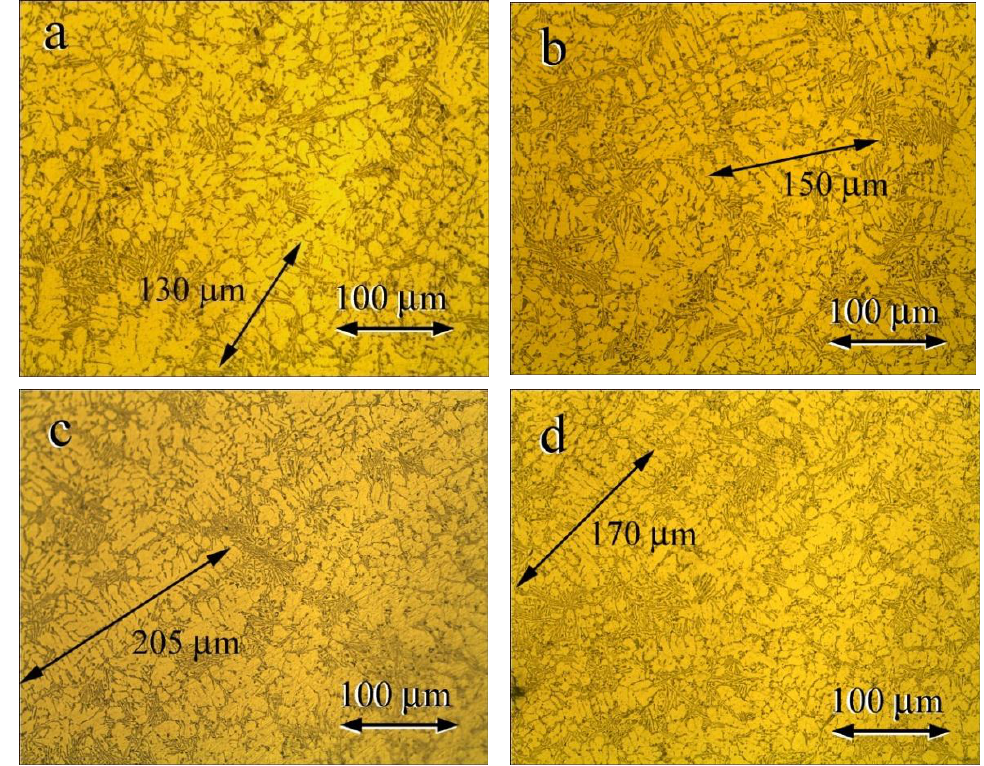
Figure 4. Microstructures of as-cast Al-Si-Cu alloys with the following Cu contents: ( a ) 0.2% Cu; ( b ) 1% Cu; ( c ) 2% Cu; and ( d ) 3% Cu.